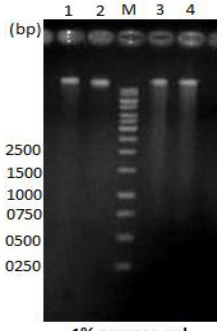
Fig. 3. Total genomic DNA of the sperm in the agarose gel electrophoresis: Line1, normospermic; Line2, 3 and 4, asthenoteratospermic.